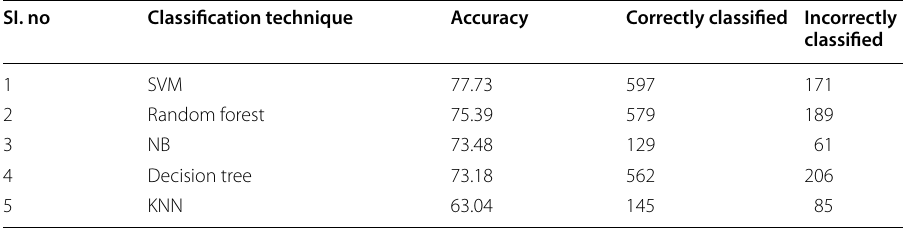
Table 2 Results of classification technique SI.